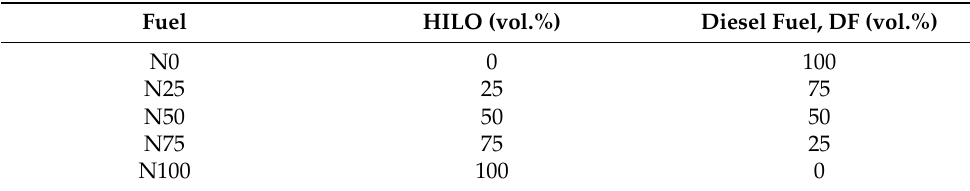
Figure 2. Fuel samples; from the right N100, N75, N50, N25, and DF. Table 1. Naming of the diesel fuel-HILO blends.